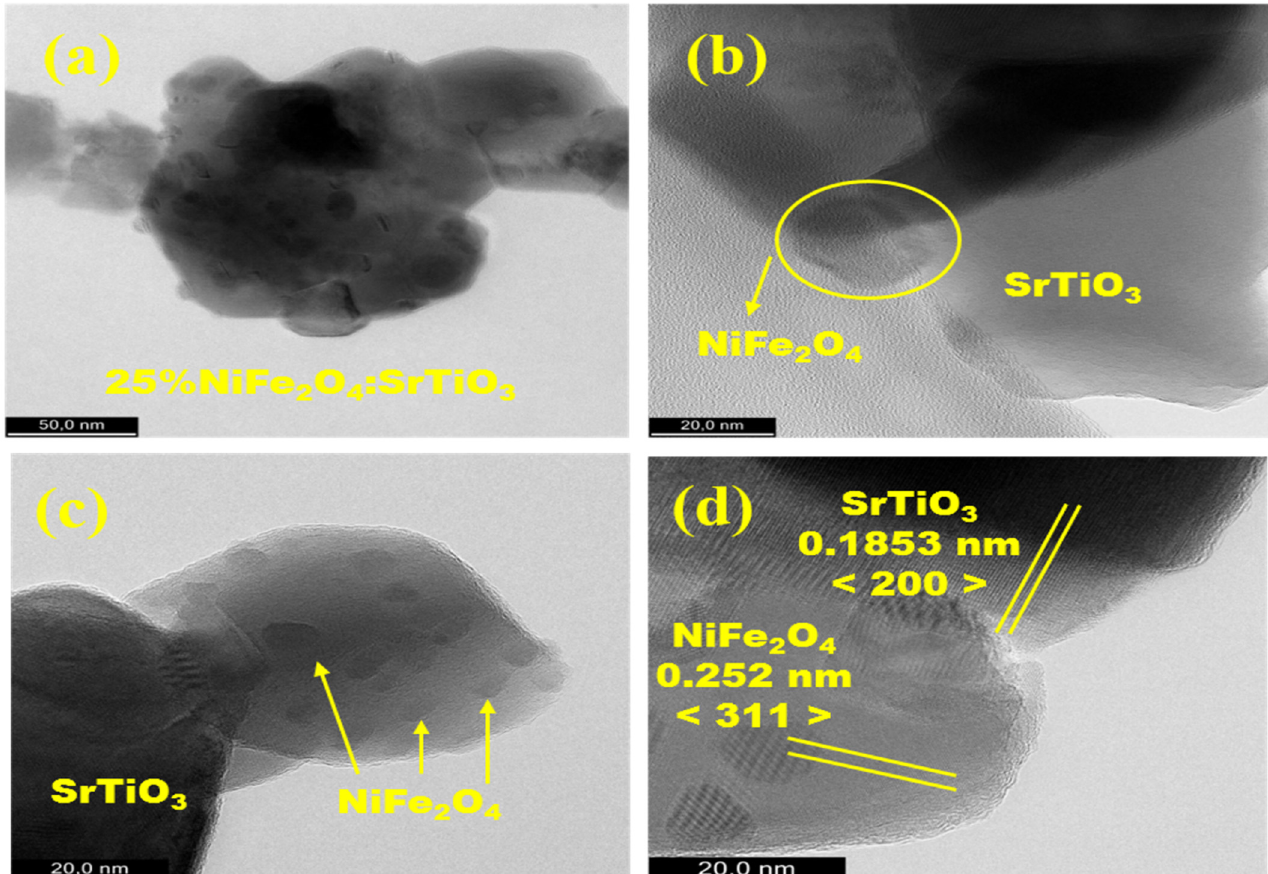
Figure 4. TEM image of the 75 STO/ 25 NFO structure [scale 50nm] ( a ), HR-TEM image of the optimum holey interconnected NiFe 2 O 4 nanoparticles with polyhedral SrTiO 3 nanoparticles [scale 20 nm] ( b – d ).